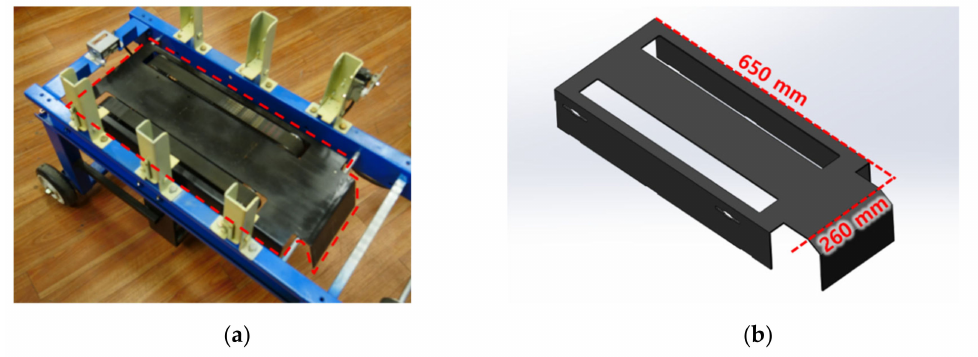
Figure 3. Shape of elevator plate: ( a ) picture and ( b ) 3D model.